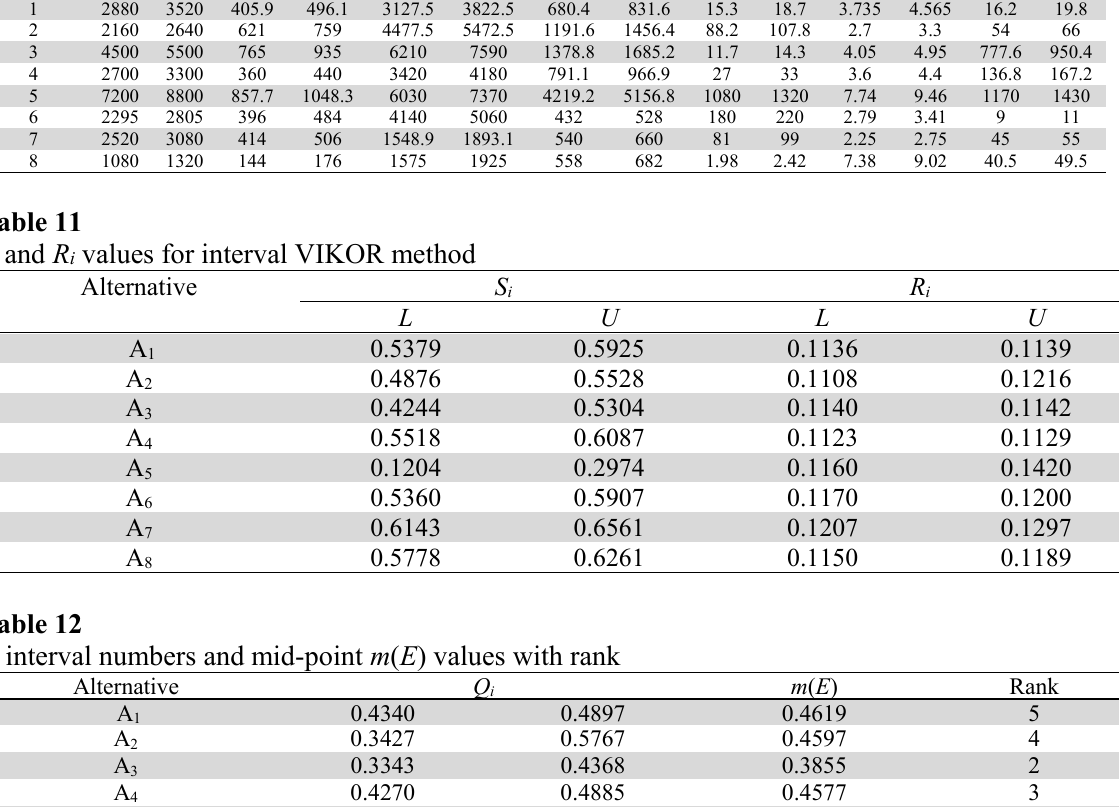
Decision matrix for interval VIKOR method Alternative